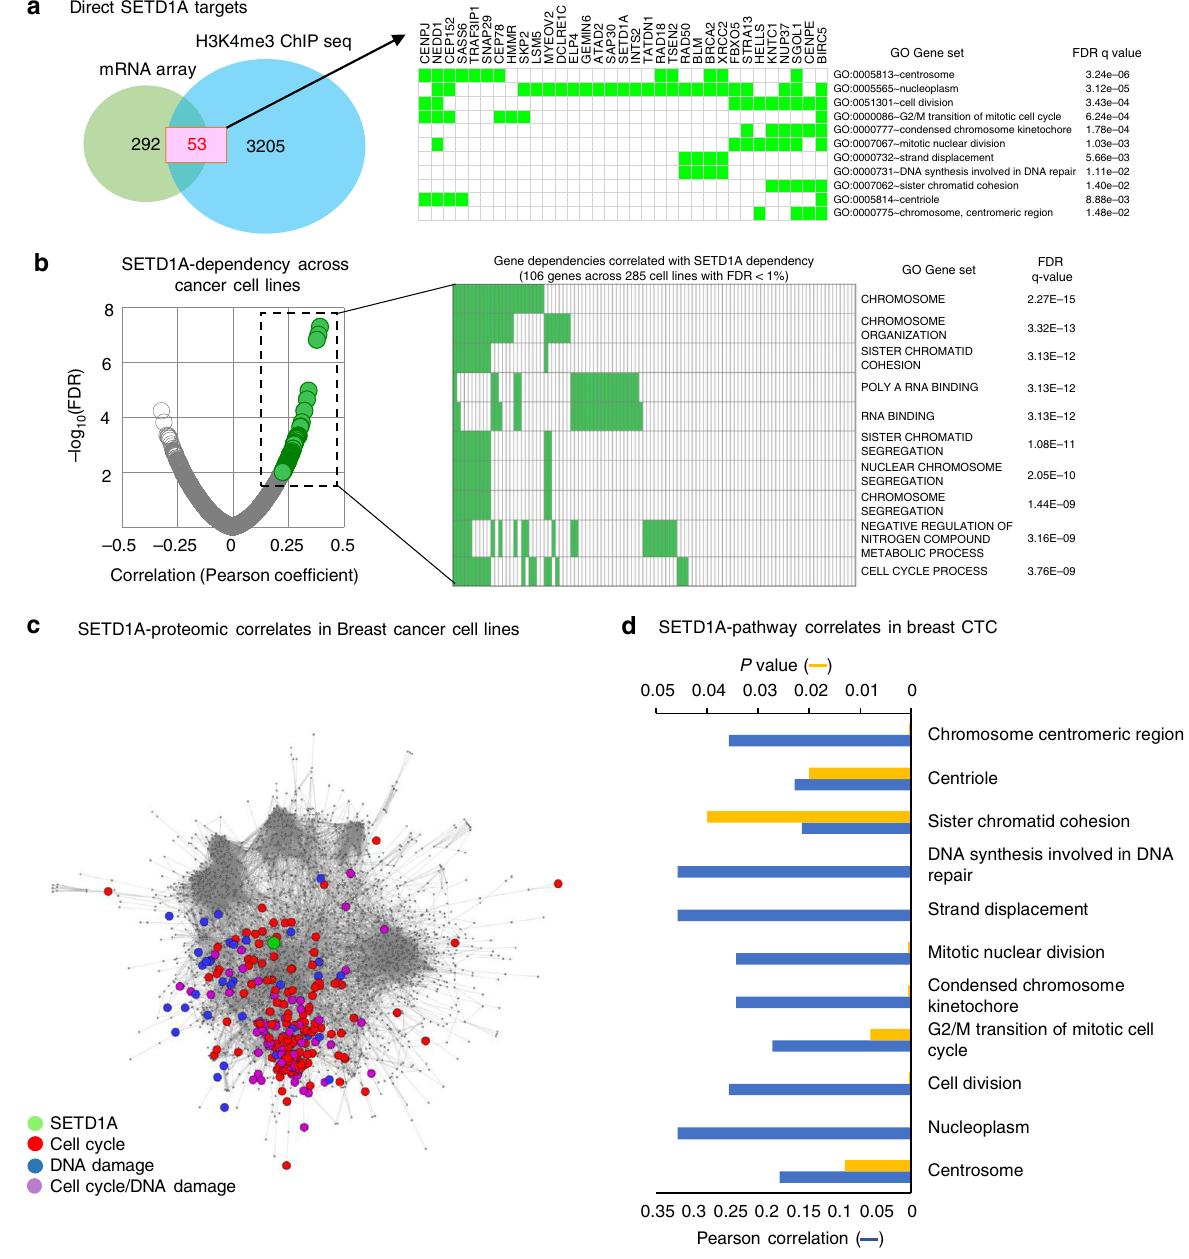
Fig. 3 SETD1A regulates mitosis, cell cycle and DNA damage response genes. a Left: Transcriptome analysis of SETD1-KD A549 and MDA-MB-231 cells identi fi ed 345 genes suppressed across both cell lines (Supplementary Fig. 3a). shGFP-cells were used as control. Comparison of these 345 genes against 3258 H3K4 methylation marks suppressed in SETD1A-KD cells identi fi ed 53 direct SETD1A targets (Supplementary Fig. 3a). Right: The 53 SETD1A targets are enriched for targets involved in mitosis, cell cycle regulation and DNA damage response. Genes contributing to the enrichment of each pathway and FDR q-values are shown. b SETD1A-dependent cancer cells are sensitive to inactivation of genes involved in cell cycle and mitosis Left: 17,079 gene dependencies were ranked by correlation with SETD1A dependence across 285 cancer lines, as measured by Project Achilles (DEMETER v2.20.2 gene scores). Pearson coef fi cient vs. -log FDR is plotted for each gene (gray), and signi fi cant direct correlates are highlighted (green, FDR < 1%). Right: GSEA on the 106 gene dependencies best correlated with SETD1A dependence (black square in Fig. 2b on the left). Top 10 most signi fi cant overlaps, accounting for 57% of genes analyzed, are shown. 7/10 GO gene sets are associated with sister chromatid cohesion. c Analysis of high-throughput quantitative proteome data from 41 breast cancer lines shows that endogenous baseline SETD1A protein expression correlates with pathways involving mitosis, cell cycle and DNA damage responses. Cytoscape network map depicting proteins enriched by greater than log 2 (0.5) by quantitative MS (GSEA FDR ≤ 0.25; Nominal p value cutoff < 0.05). The heatmap displaying the hierarchical clustering of leading-edge proteins related to the processes indicated are shown in Supplementary Fig. 3d. The full set of gene enrichment results are provided in Supplementary table 1. d SETD1A expression in CTCs from metastatic breast cancer patients correlates with the expression of SETD1A-targets involved in cell cycle, mitosis and DNA damage responses. Graph shows the Pearson correlation coef fi cient between the leading edge-genes identi fi ed for each of the gene signatures shown in ( a ) and SETD1A expression in RNASeq data from single CTCs derived from breast cancer patients 29,30 . The p values for each pathway is provided. Source data are provided as a Source Data fi